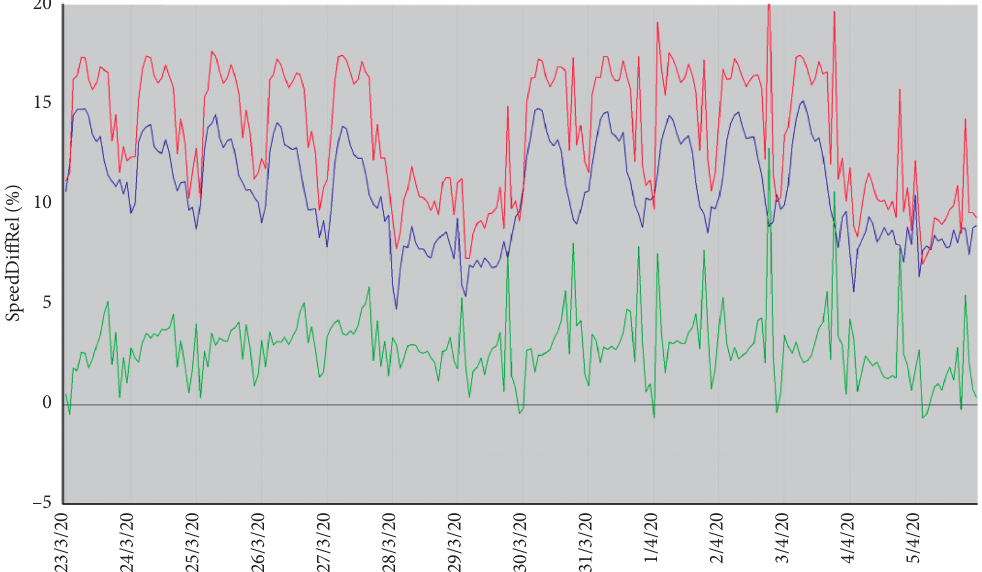
Figure 10: Two-week period from 23 March to 5 April 2020. SpeedDiffRel in percentage points by hours.